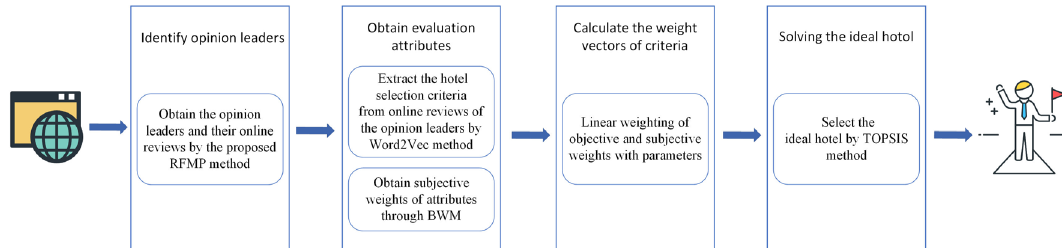
Fig. 1 The structure of a novel hotel selection decision support